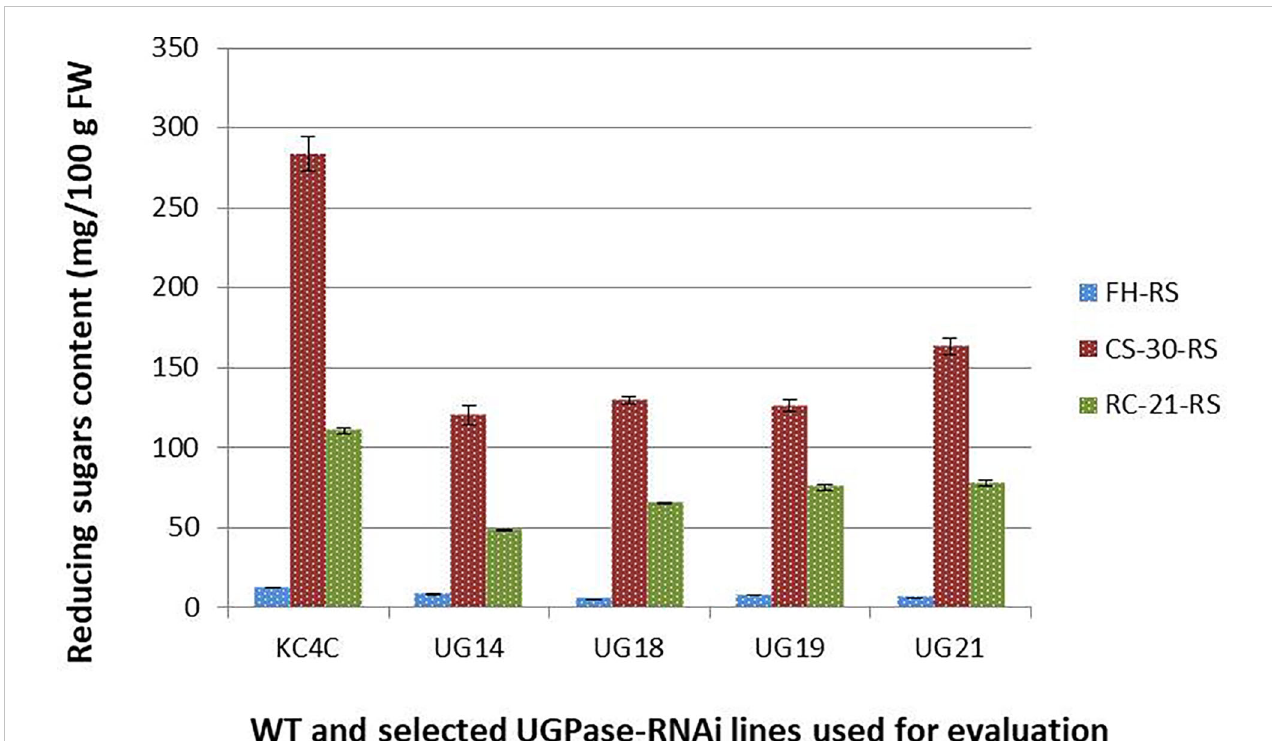
FIGURE 4 Reducing sugar content in the UGPase RNAi potato transgenic lines of KC4. KC4C, Kufri Chipsona-4 control; UG14, UG18, UG19, and UG21 are the four selected UGPase RNAi transgenic lines of KC4.FH, Fresh harvest; CS-30, cold stored for 30 days; RC-21, 21 days reconditioning at room temp after cold storage.